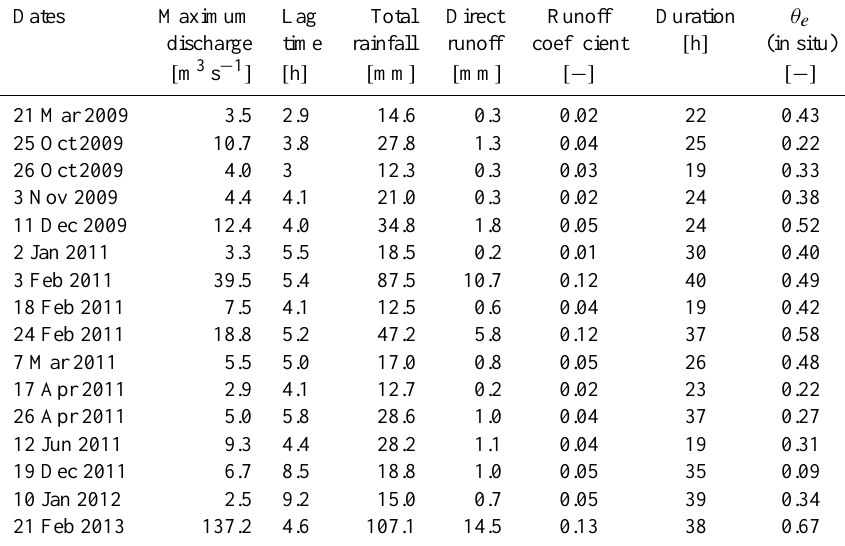
Table 1. Main characteristics of the selected rainfall–runoff events. θ e represents the in situ relative soil moisture at the beginning of each selected event.